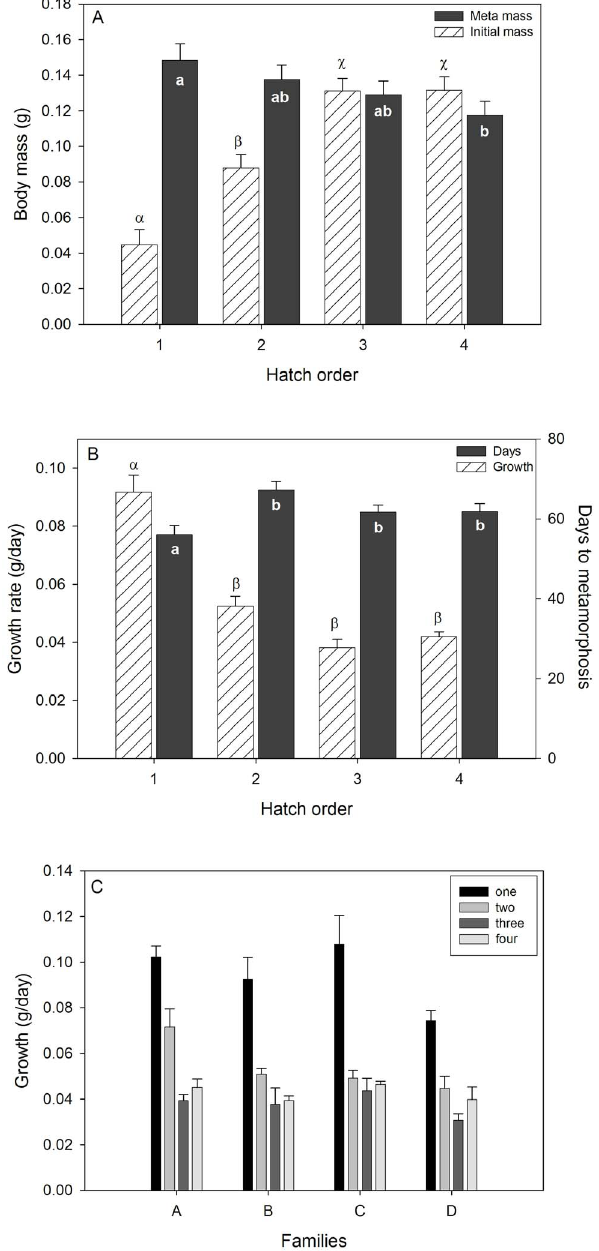
Figure 2. The effects of hatching order and family body mass, metamorphic traits and growth rates. Hatching order influenced body mass at hatching and at metamorphosis for tadpoles reared in isolation (A). Hatch order also influenced growth and developmental rates (B). Family (i.e. egg clutch) did not influence growth rates (C). Differing letters or symbols denote significant differences between hatch orders for each trait (Tukey HSD test, P , 0.05).